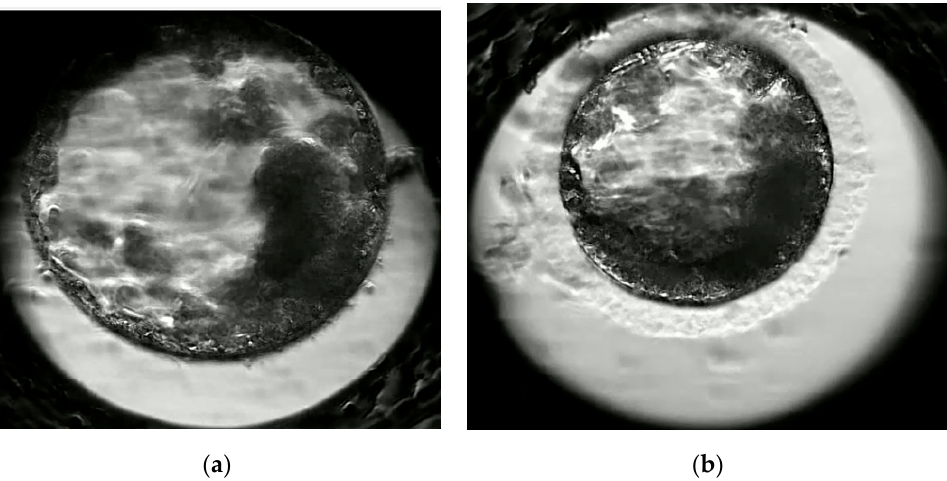
Figure 3. Blastocysts of adult ( a ) and prepubertal ( b ) domestic cat at 165 h post in vitro fertilization (IVF).